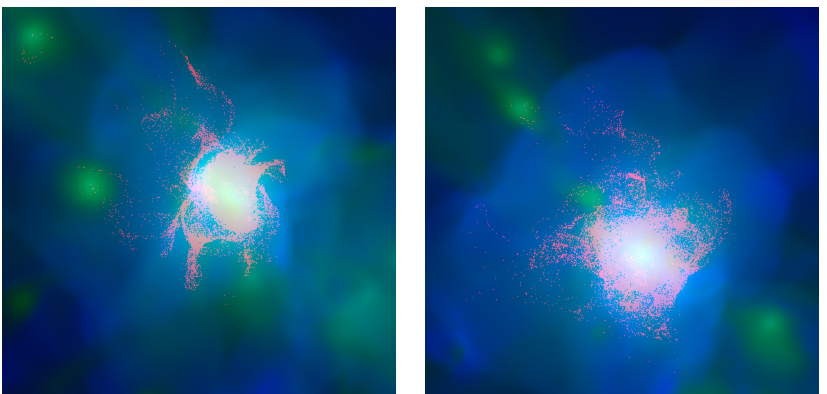
Figure 6. Red–green–blue composite images showing two evolved snapshots ( z = 0.102 and 0.032, respectively) of the model in which electrons are seeded by merger shocks, starting from z = 0.4. Each image is 5 × 5 Mpc 2 across, and it shows the mass-weighted gas temperature along the line of sight (blue), the projected gas density (green), and the location of electron tracer, regardless of energy (red). These two panels match the final two snapshots of the ones in Figure